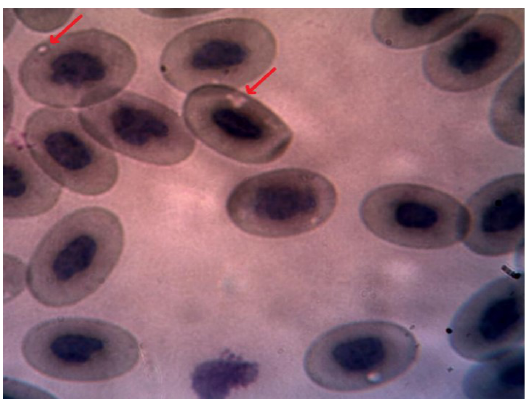
Fig. 3. Sepentoplasma in blood cells of Natrix